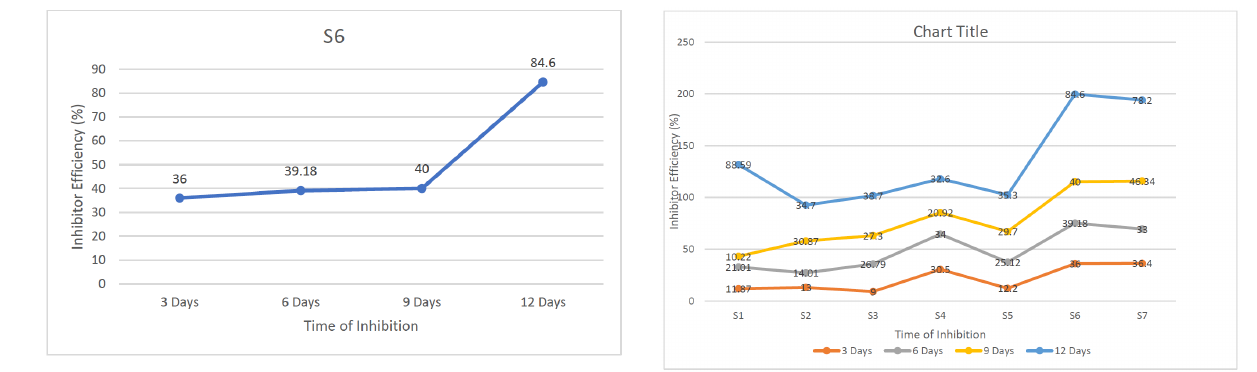
Figure 9: Plot of Inhibition eflciency versus Time of inhibition (days).